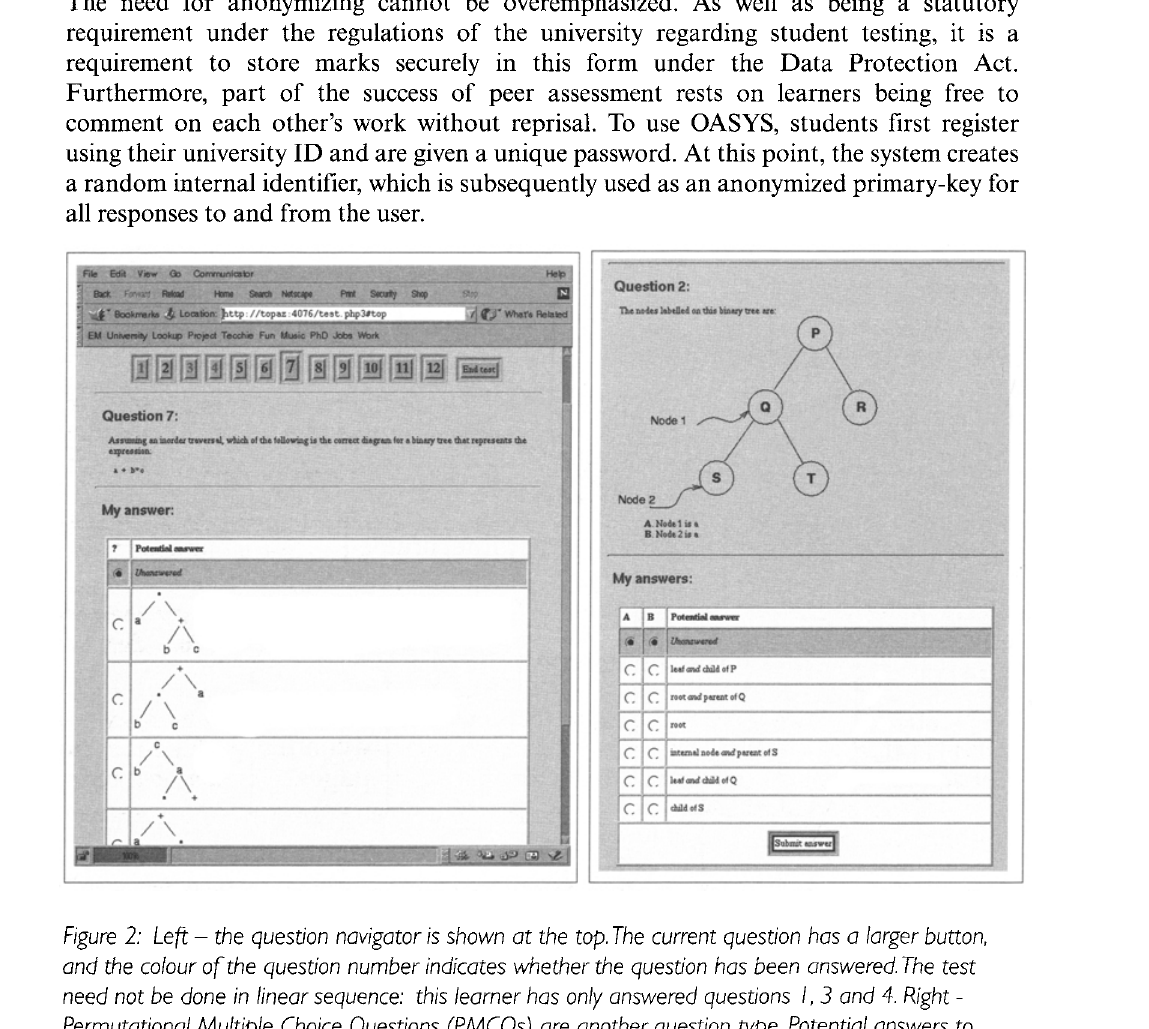
Figure 2: Left - the question navigator is shown at the top. The current question has a larger button, and the colour of the question number indicates whether the question has been answered The test need not be done in linear sequence: this learner has only answered questions I, 3 and 4. Right - Permutational Multiple Choice Questions (PMCQs) are another question type. Potential answers to both MCQ and PMCQs are jumbled up randomly (akthough deterministicatly - this learner wilt always see this question this way) so that answers cannot be copied from a nearby